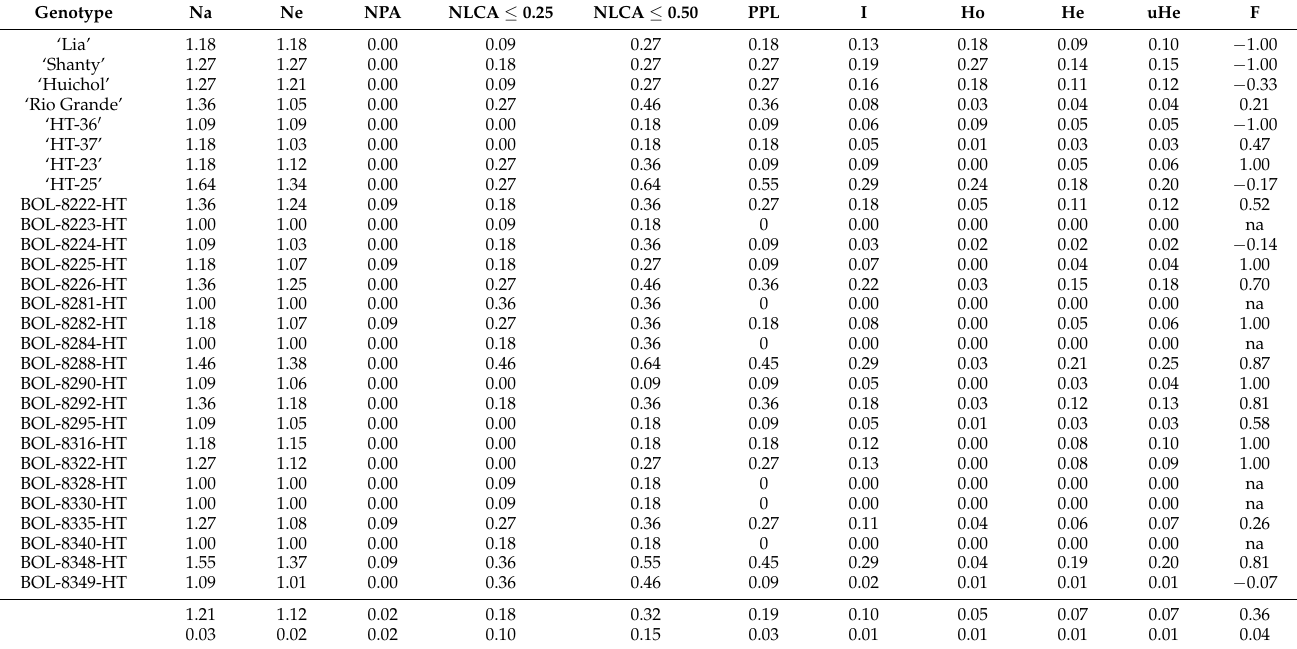
Table 3. Estimates of different population genetics parameters for the 28 tomato accessions